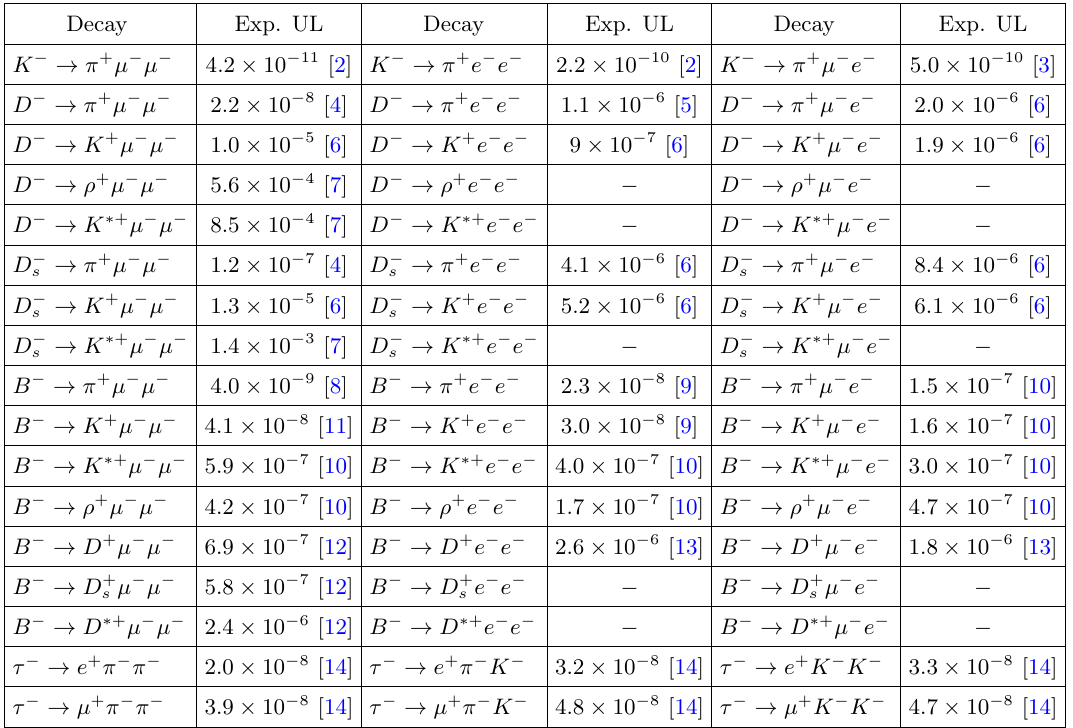
Table 2 . Experimental upper limits (Exp. UL) on the LNV three-body decays of the mesons and (cid:28)